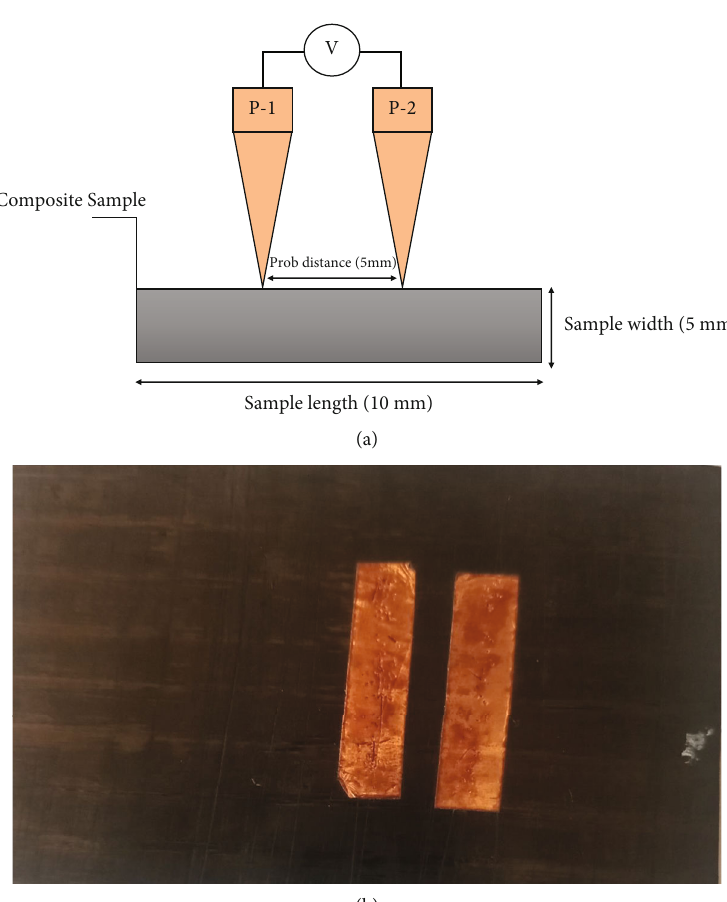
Figure 5: Schematic diagram of (a) two-probe DC conductivity tester and (b) composite sample with copper conducting tape for DC conductivity